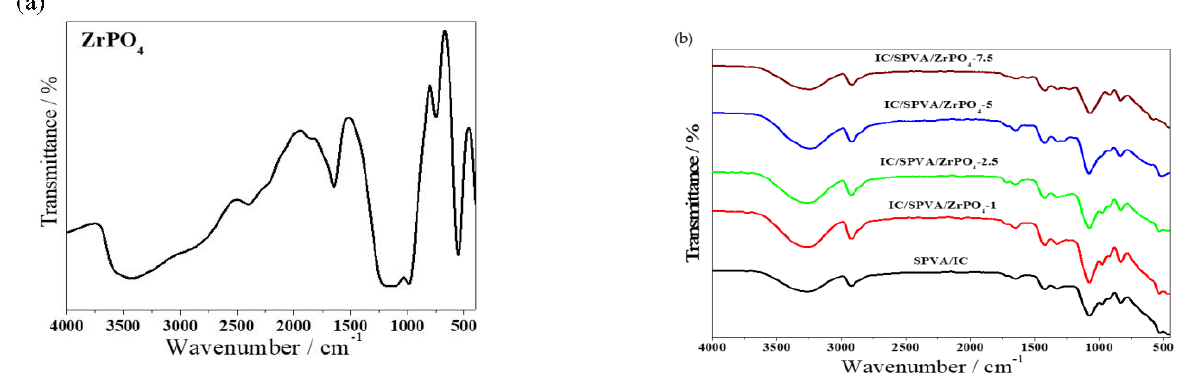
Figure 2. FTIR of ( a ) zirconium phosphate and ( b ) IC/SPVA/ZrPO 4 membranes.